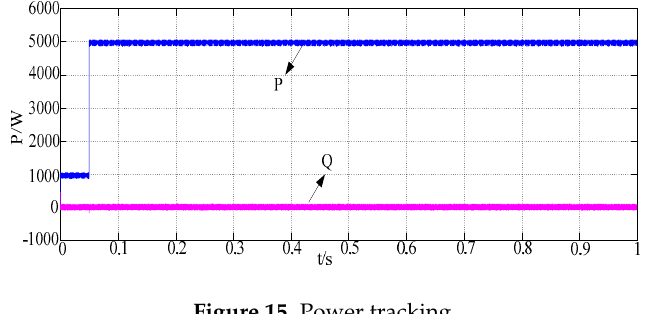
Figure 14. Capacitor voltage of C1 and C2 .